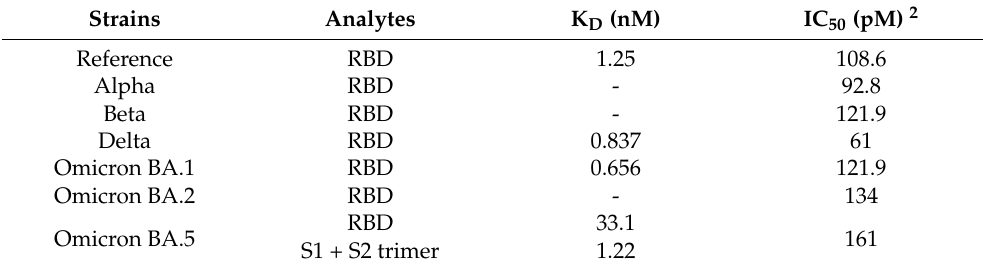
Table 1. Summarization of data between different SARS-CoV-2 strains 1 . Figure 1. SPR-based characterization of Kansetin’s binding affinity to Spike RBD protein of SARS-